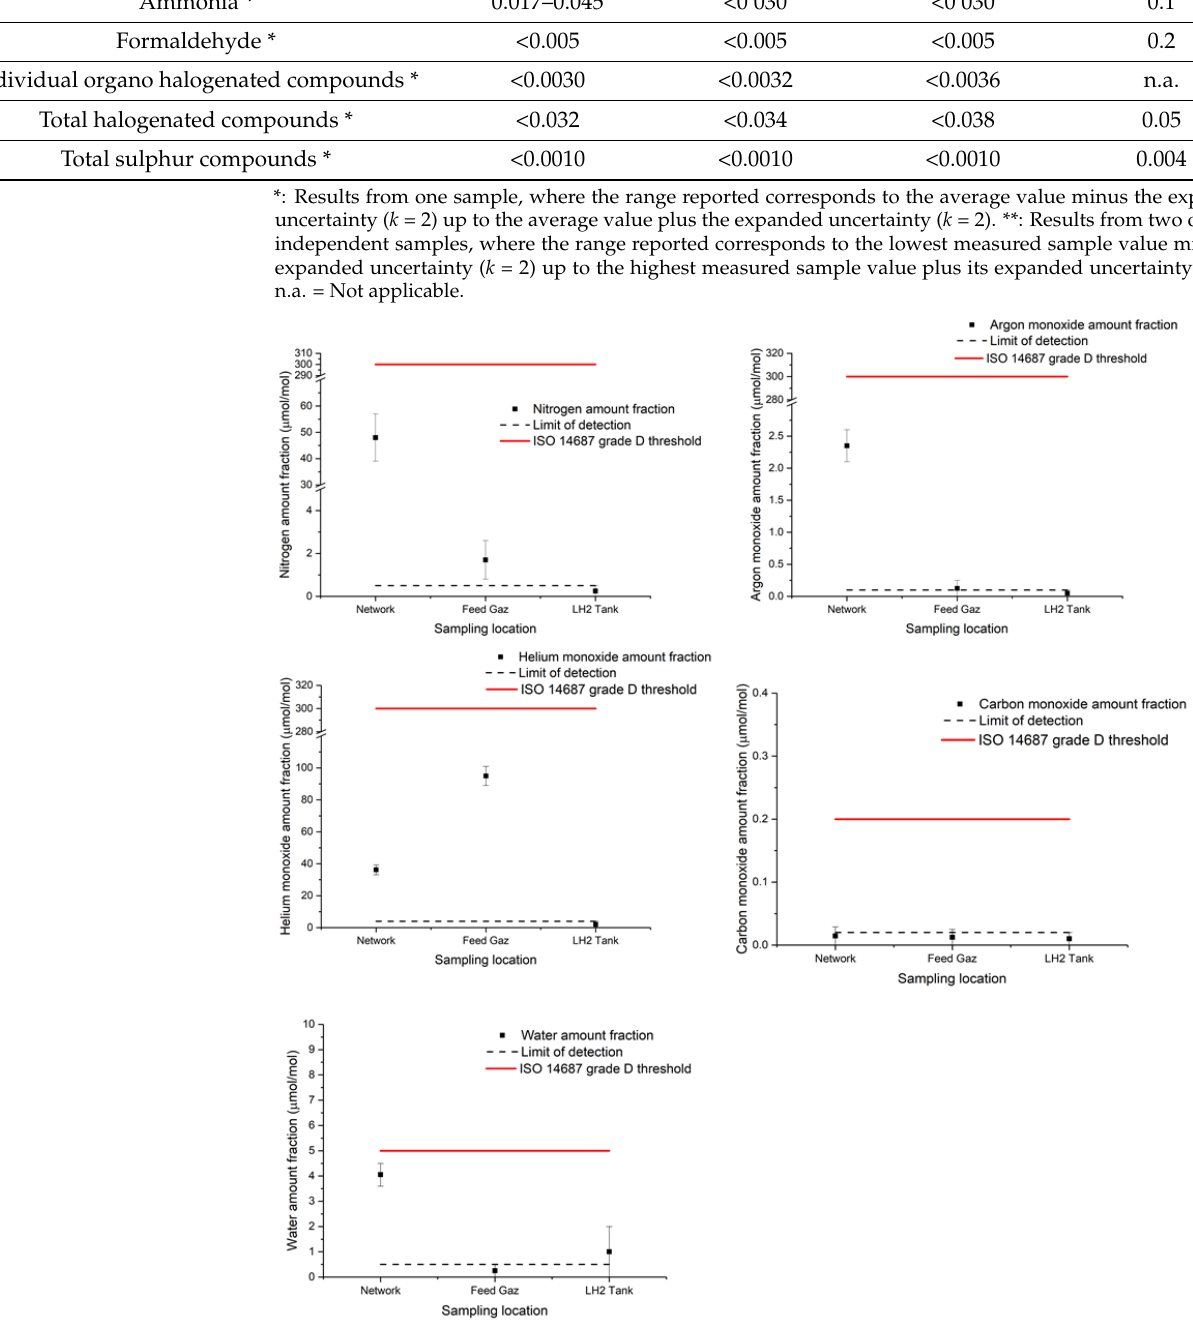
Figure 2. Graphical representation of hydrogen gas contaminant results for nitrogen, argon, helium, carbon monoxide and water during the liquefaction process (network, feed gas and LH2 tank). In the network, the presence of nitrogen, helium, argon, water and carbon dioxide was found. Traces of non-methane hydrocarbons, carbon monoxide and ammonia were visible but close to the limit of quantification. In the feed gas, the presence of nitrogen and helium was also detected. Traces of argon, carbon dioxide, carbon monoxide and oxygen were visible but close to the limit of quantification of NPL analytical methods. All the other impurities were reported below the limit of detection of the analytical methods and much lower than the ISO 14687:2019 threshold values. Even if the hydrogen network and feed gas were compliant with the ISO 14687:2019 requirements, few impurities were observed at quantifiable levels before the liquefaction process. The results of analysis at the LH2 tank showed the presence of only one quantifiable compound: water. All the other impurities were below the limit of detection of the ana- lytical methods and much lower than the ISO 14687:2019 reference values. The results showed that, after the liquefaction process, the hydrogen gas presented less quantifiable impurities (Figure 2). The results seem coherent with the assumption that the liquefaction process has a purification effect on the hydrogen gas boil-off.